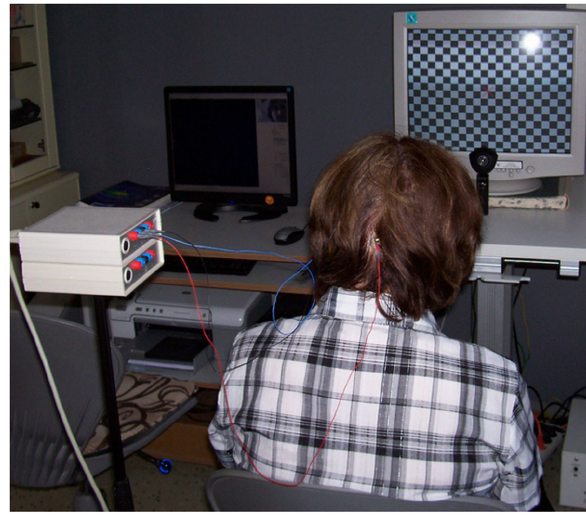
Fig. 1. Calculation of objective visual acuity with extrapolat- ing measured amplitude during sVEP method (Fahad 13 ).